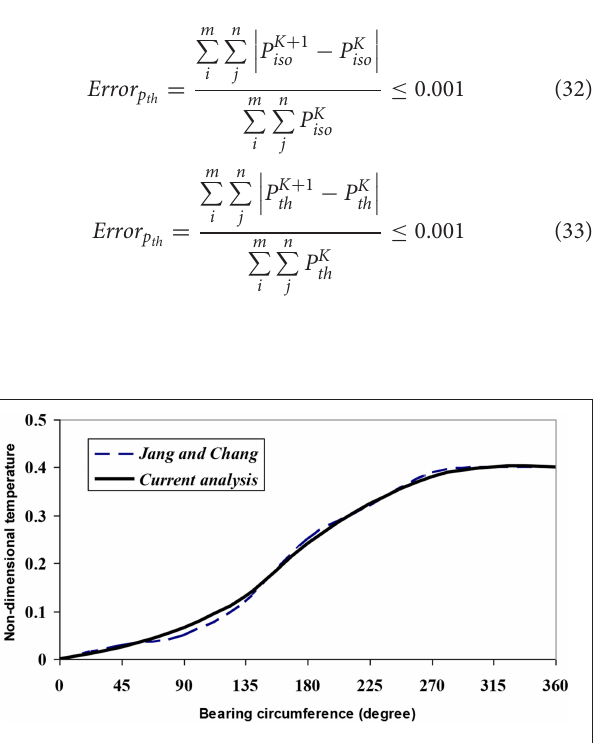
FIGURE 5 | Validation of temperature.